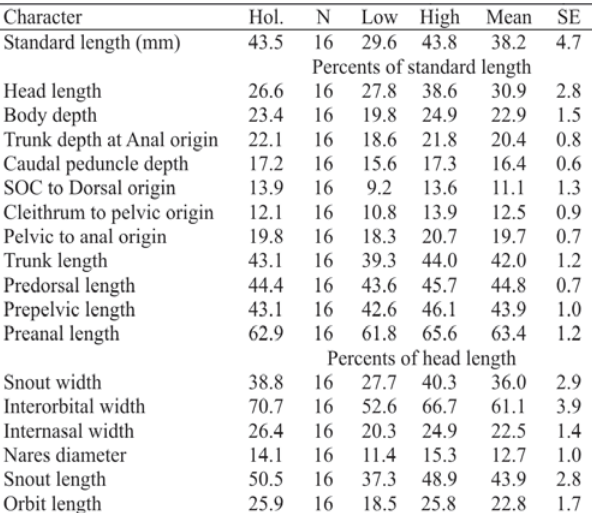
Table 1 . Descriptive morphometrics of Otocinclus cocama . Values are given for the holotype and ranges given for the 16 remaining specimens. SOC = parieto-supraoccipital posterior process; SD = standard deviation; Hol = holotype.